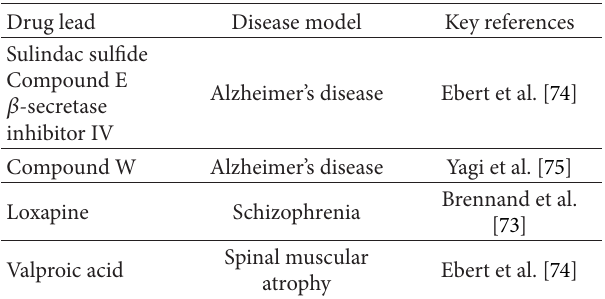
Table 2: Examples of drug leads screened with hPSCs-derived neuronal